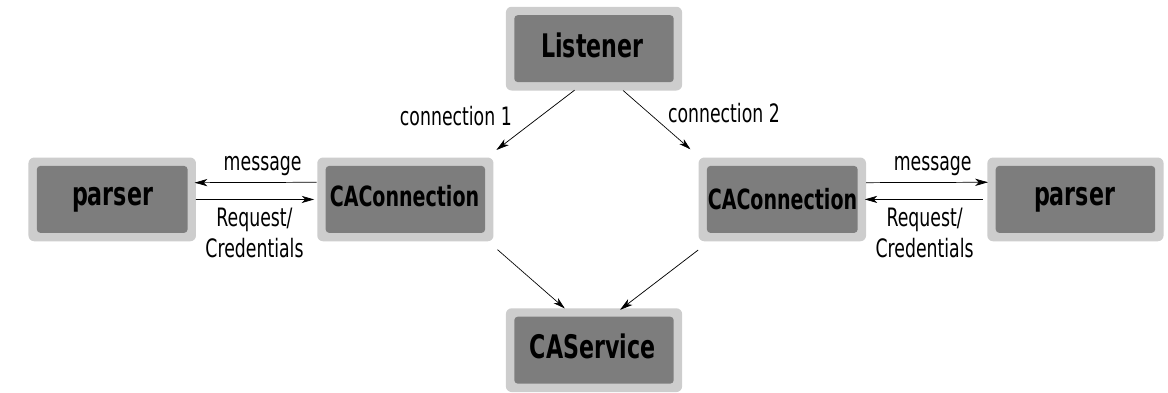
Figure 4. By enforcing that compartments can only be accessed via unforgeable references, stronger security guarantees can be guaranteed. Even if an attacker is able to exploit a vulnerability in a parser, she will be unable to access Request / Credentials compartments belonging to another